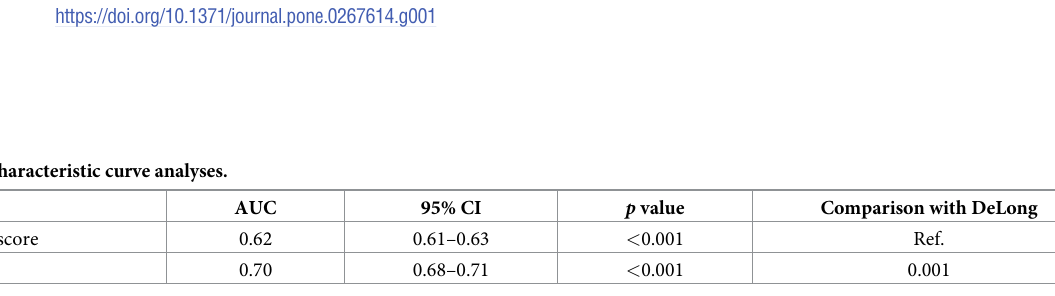
Fig 1. The receiver operating characteristic analysis showing the prognostic value of ACC/AHA ASCVD risk score and baPWV. ACC/AHA ASCVD, American College of Cardiology/American Heart Association atherosclerotic cardiovascular disease; baPWV, brachial-ankle pulse wave velocity.